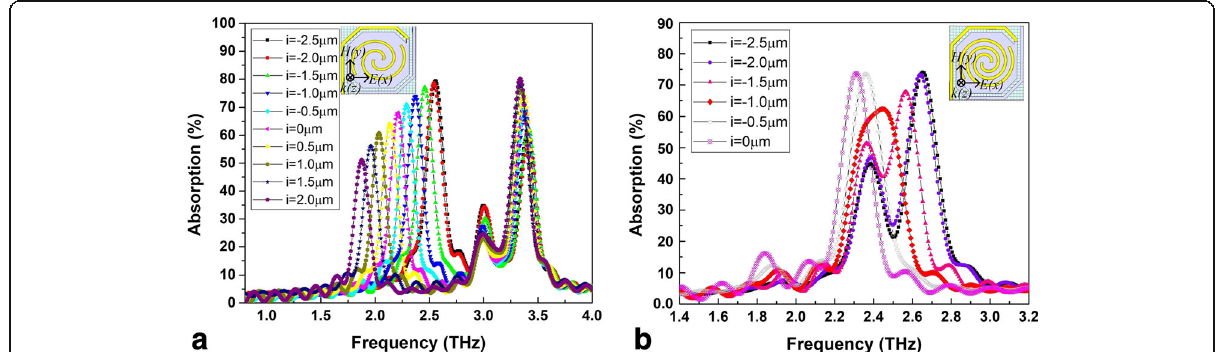
Fig. 4 THz wave absorption curves of spiral-type antenna-coupled micro-bridge structures with a single separate linear antenna on one of the bridge legs when n = 1.1 ( a ) and n = 1.6 ( b ) for different linear antenna positions